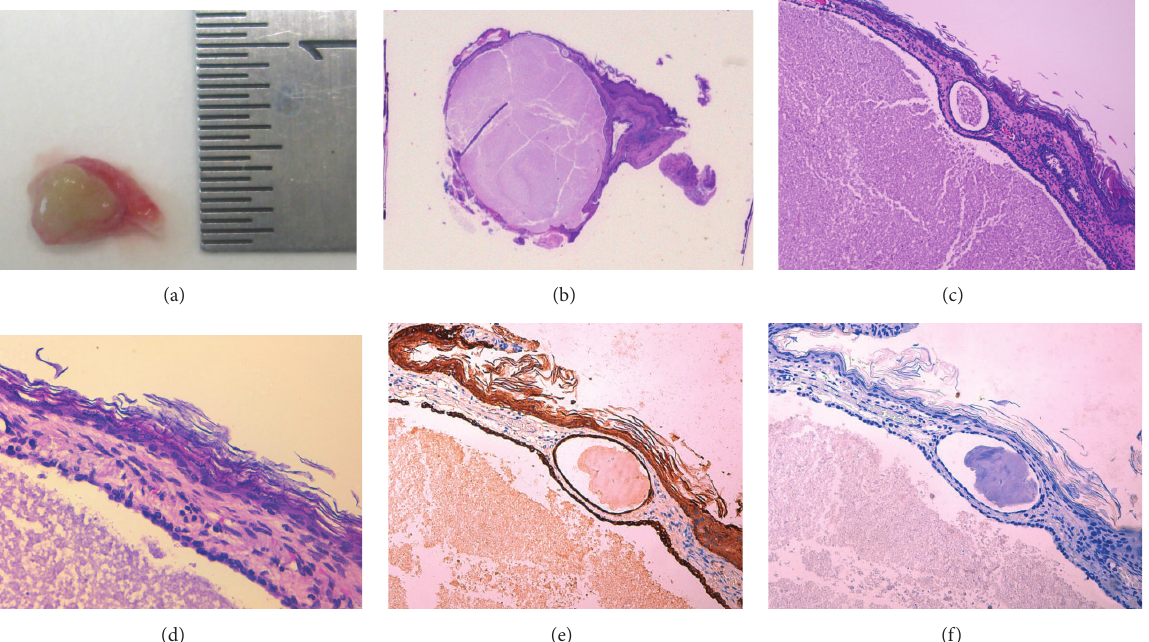
Figure 2: A 0.5 cm yellowish nodule (a). Histological macroview (HE 1.5x) (b). Multiloculated cystic formation lined by a monostratified nonmucin productor cuboidal epithelium (400x HE and 630x HE) (c) and (d). Immunohistochemical analysis shows cytokeratin-positive cells (AE1 and AE3) (e) and negativity for S100 protein, neural specific enolase, glial fibrillary acidic protein (GFAP), and synaptophysin (400x)